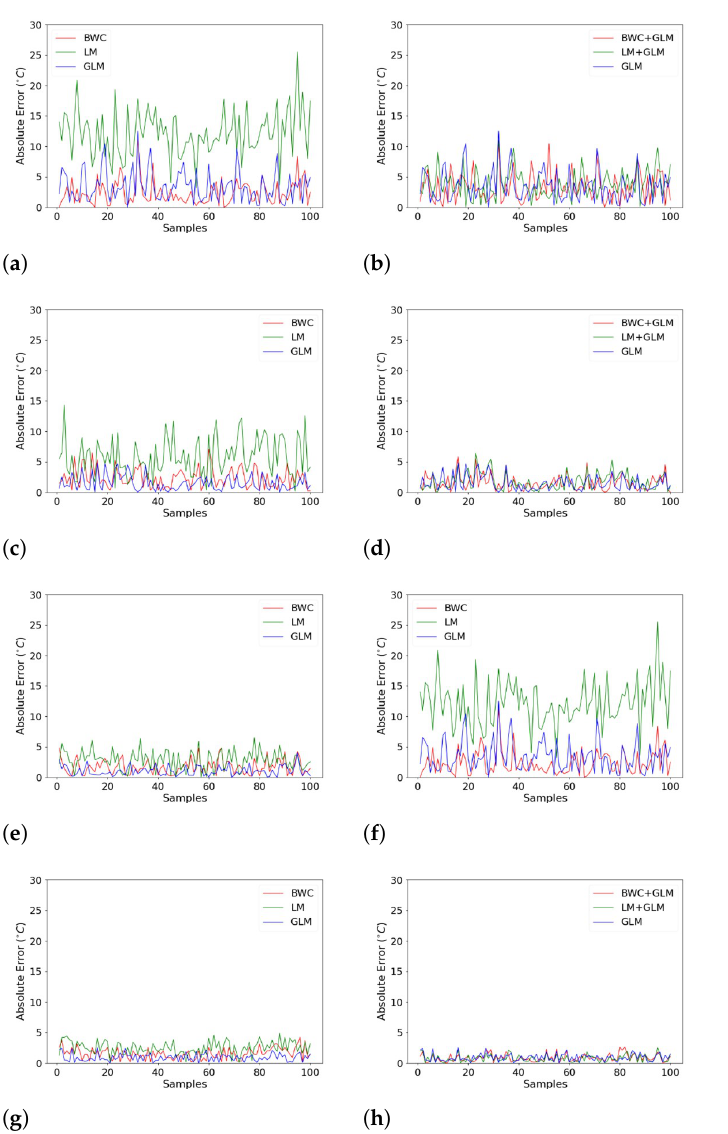
Figure 7. The absolute error results obtained after data processing: ( a ) − 2 dB single processing; ( b ) − 2 dB double processing ( c ) 3 dB single processing; ( d ) 3 dB double processing; ( e ) 6 dB single processing ( f ); 6 dB double processing; ( g ) 20 dB single processing; ( h ) 20 dB double